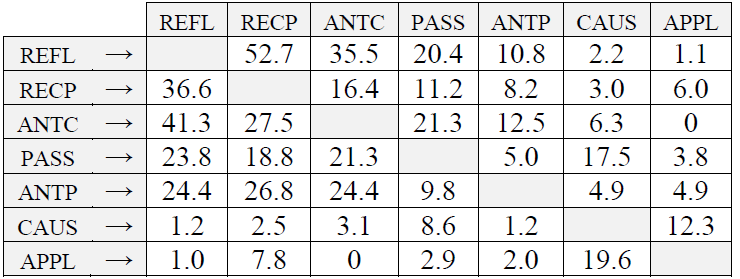
Figure 1. Probability of language featuring simplex voice